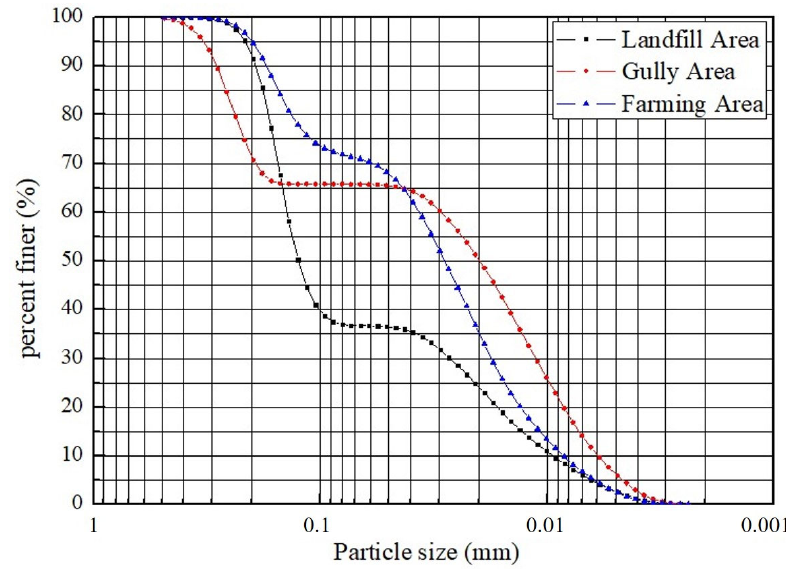
Figure 3. Particle grading characteristics in different areas.